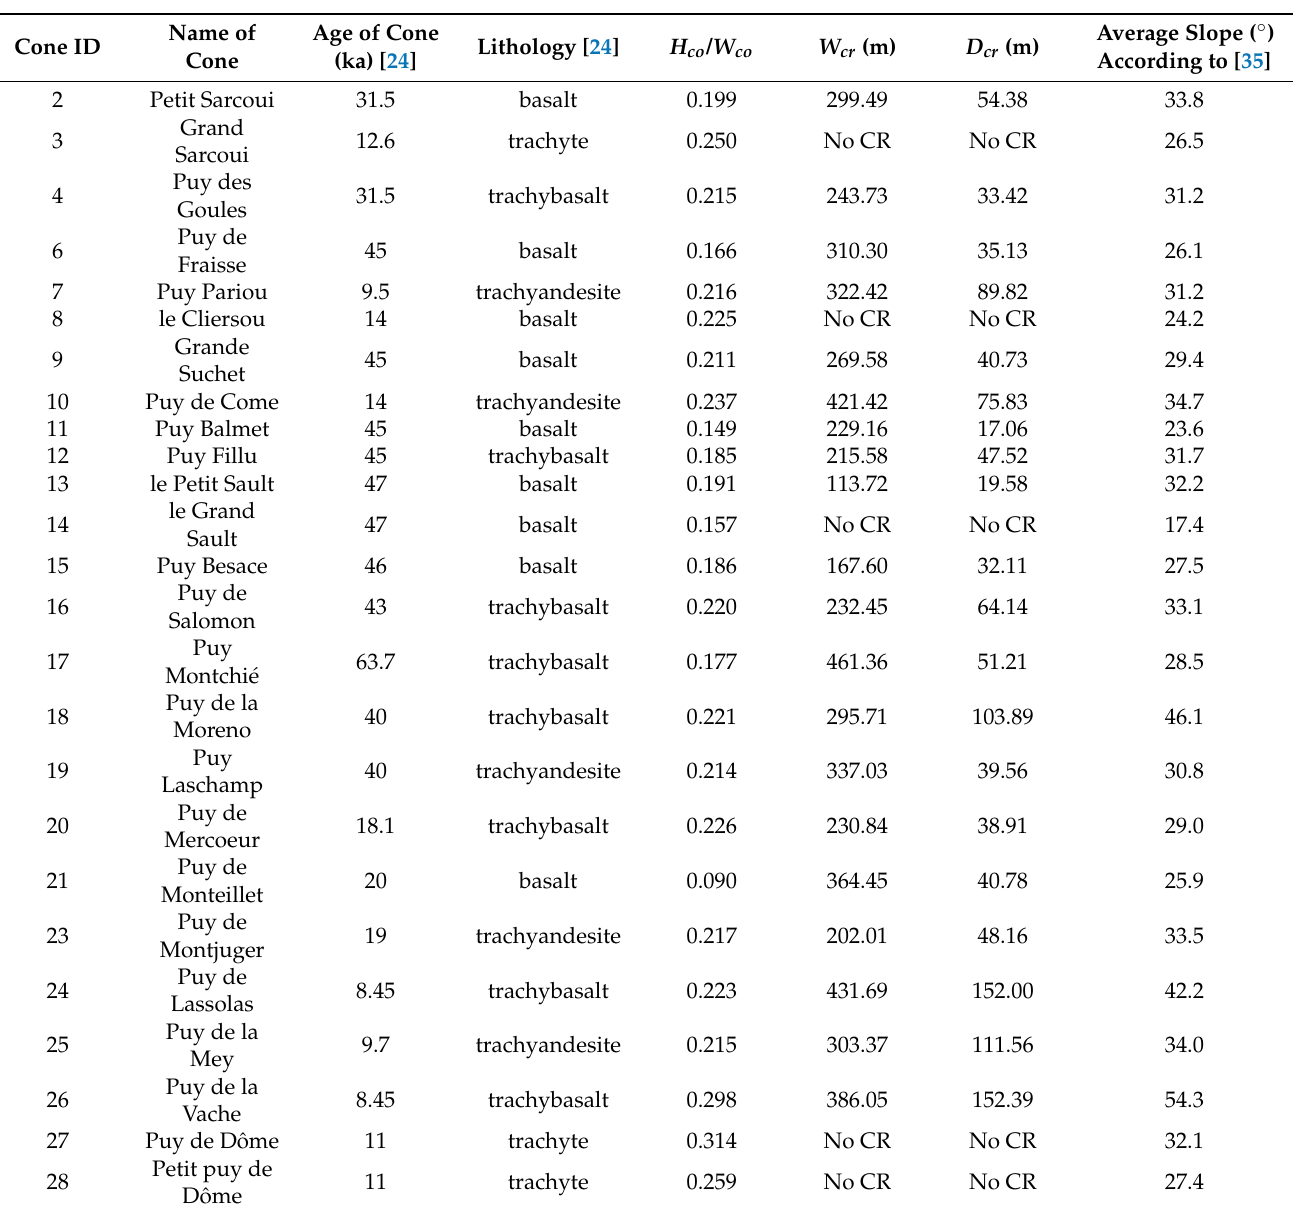
Table 1. Summary of the geology, the ages [24] and the calculated classic morphometric parameters of the scoria cones and lava domes of Chaîne des